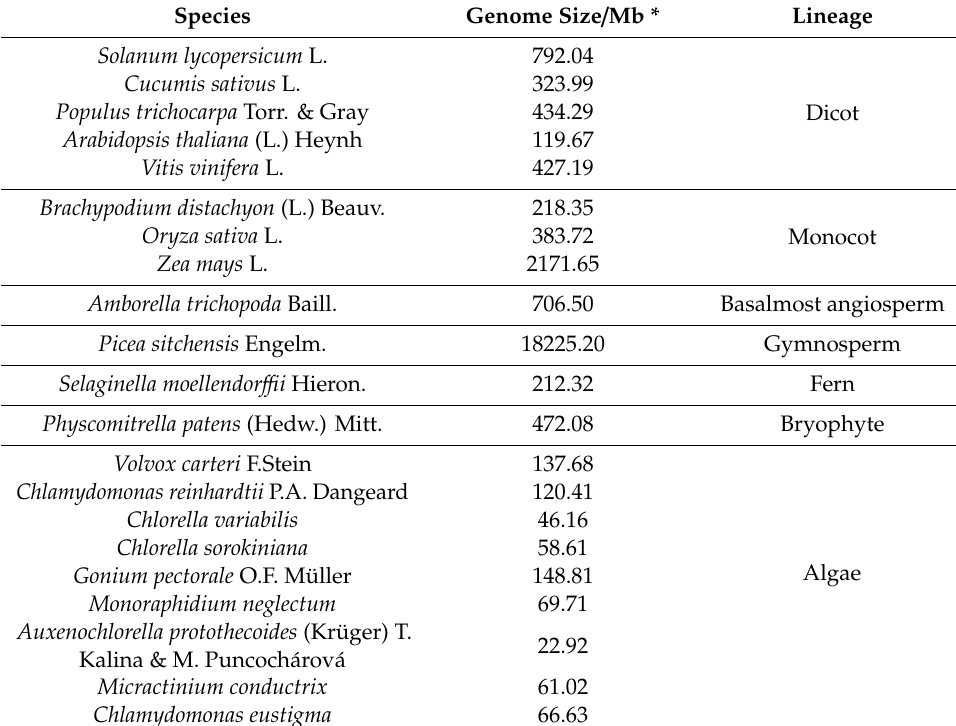
Table 1. Plant species investigated in this